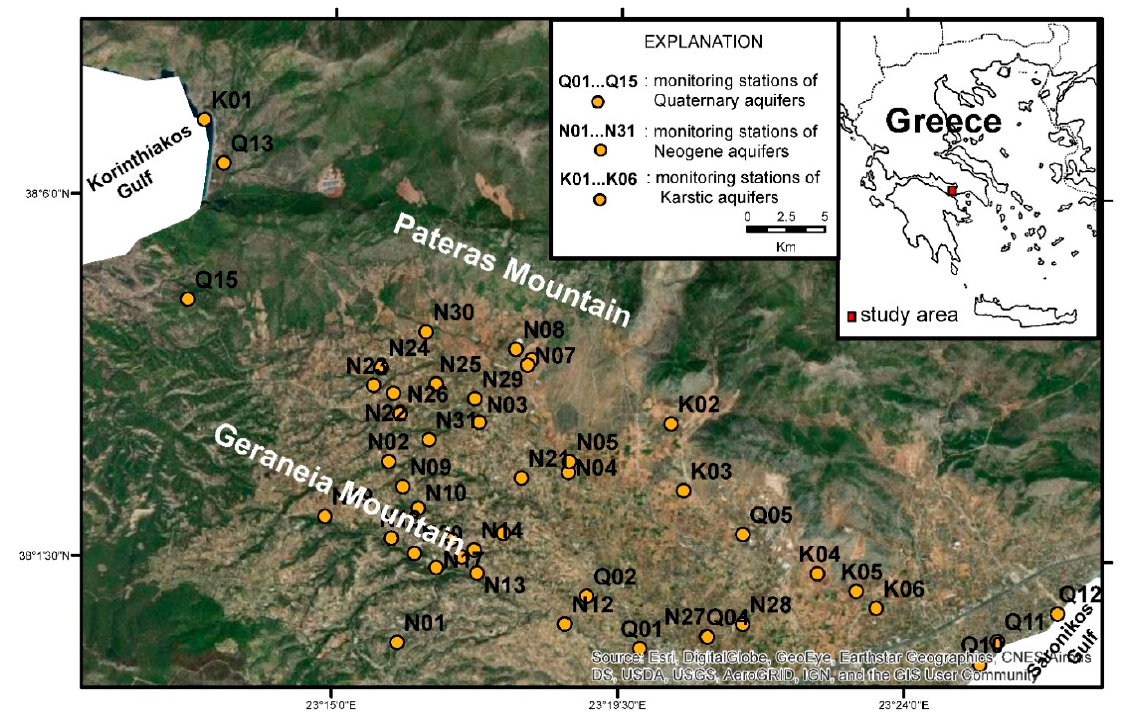
Figure 2. Map showing the area studied and groundwater monitoring stations.